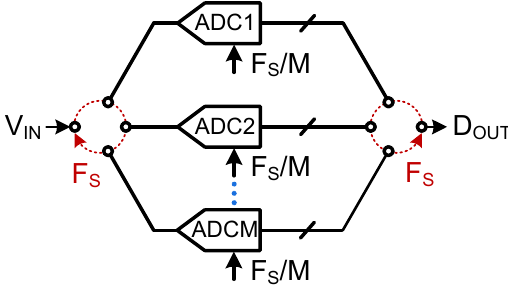
Figure 1. Conceptual block diagram of